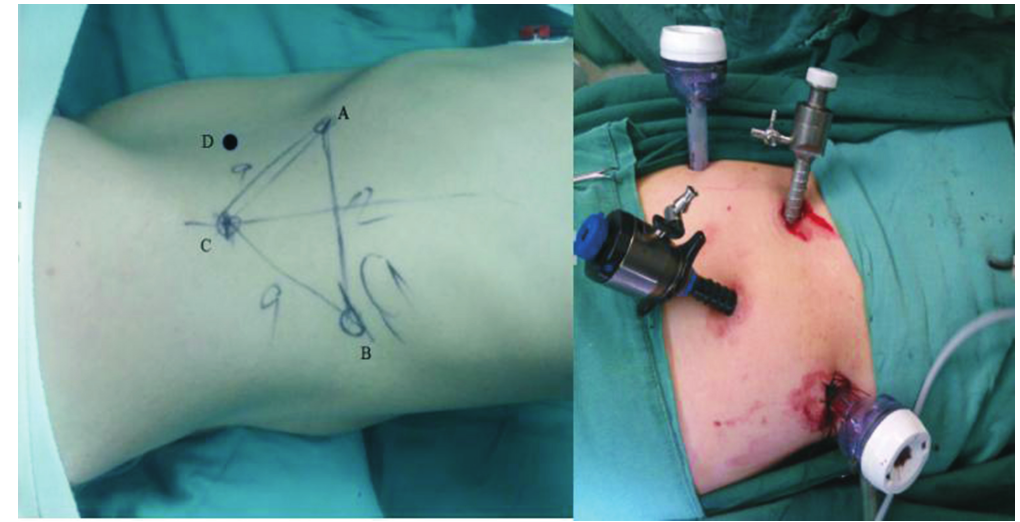
Figure 1 - Distribution of the 4 port sites (Port D was established after